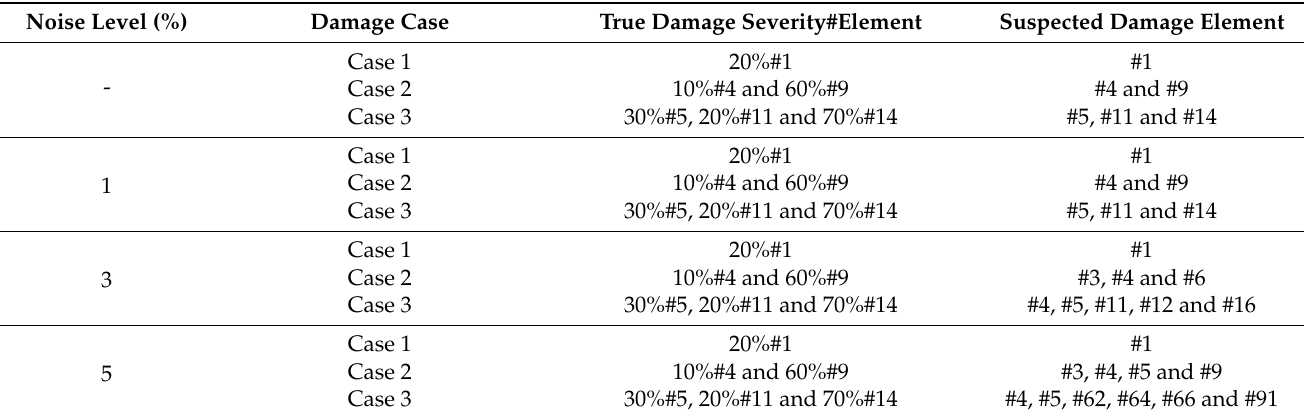
Table 4. Damage localization results of the ASCE benchmark